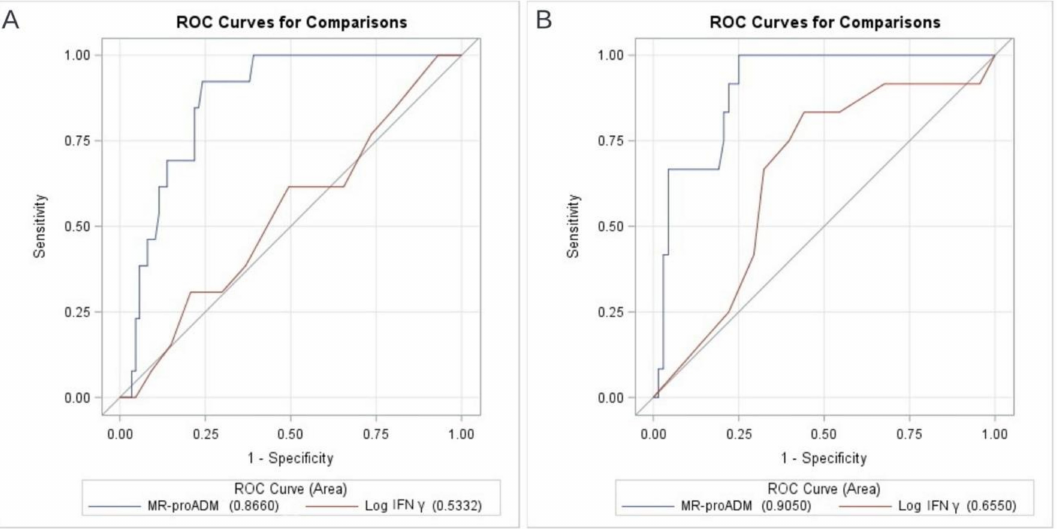
Figure 1. AUROC analysis of MR-proADM and in vitro IFN γ production for in-hospital mortality, at T0 (panel ( A )) and T1 (panel ( B